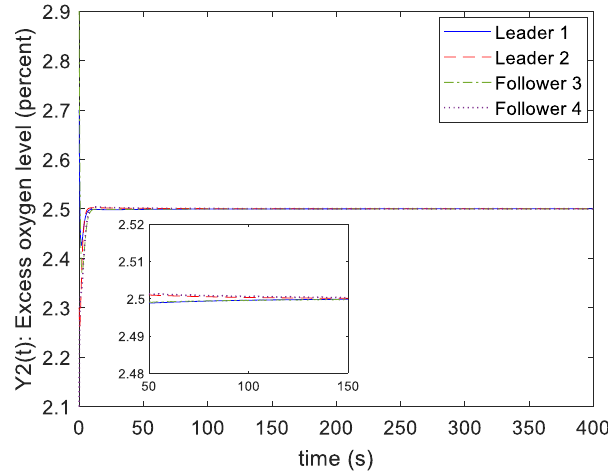
Figure 10. Responses of output Y 2 ( t ) with IT-2 fuzzy control.